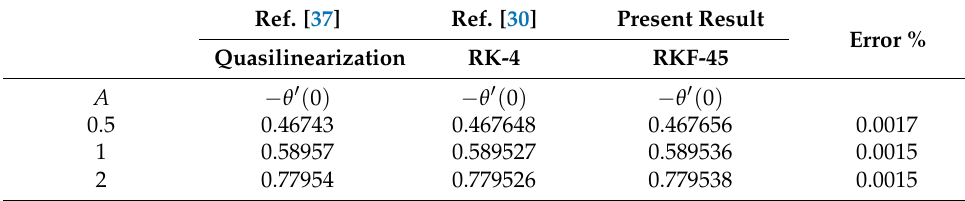
Table 7. Comparison of − θ (cid:48) ( 0 ) for several values of A in the absence of φ . Ref. [37]